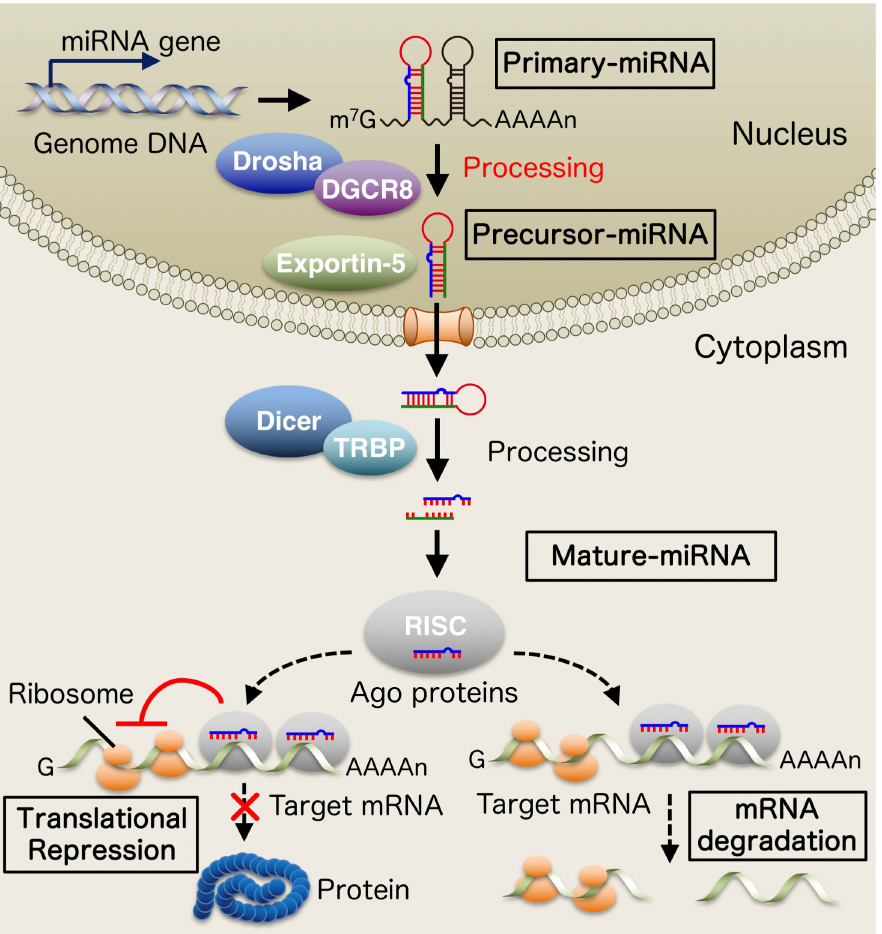
Figure 1. Biogenesis of microRNAs (miRNAs). The miRNA gene is primary transcribed by RNA polymerase II to become primary-miRNA (pri-miRNA). It is then processed by the RNase III enzyme Drosha in the nucleus to produce precursor-miRNA (pre-miRNA). Pre-miRNAs migrate to the cytoplasm in an exportin-5-dependent manner and are further processed by Dicer which interacts with a double-stranded RNA-binding domain (dsRBD) protein, TAR RNA-binding protein (TRBP) into mature microRNAs. Mature miRNAs are subsequently incorporated into an effector complex called RNA-induced silencing complex (RISC), a ribonucleoprotein complex composed of argonaute (Ago) proteins, and mature miRNAs ultimately negatively regulate gene expression by inhibiting translation or promoting degradation of target mRNA.